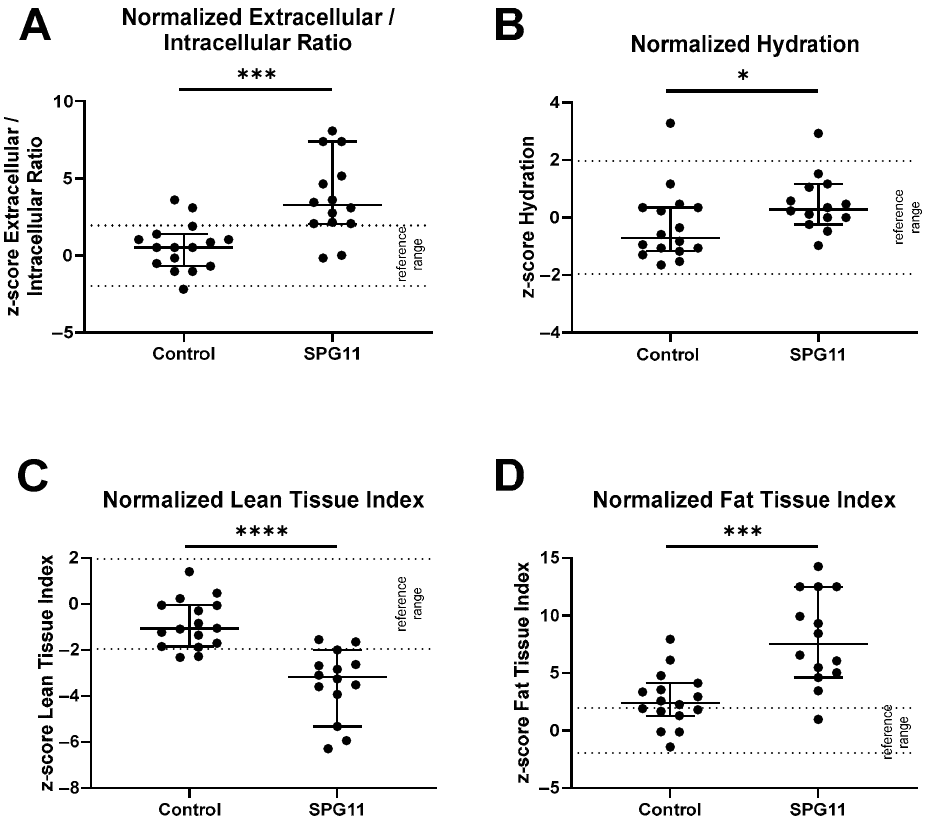
Figure 2. Normalized body composition values in controls and SPG11. Bioimpedance spectroscopy values in controls and SPG11 shown as Z-scores calculated from previously reported sex- and age- adjusted reference values from 1000 healthy subjects. Reference cutoff values had been defined by the 10th and 90th percentiles and are indicated as dotted lines. When comparing normalized values of SPG11 vs. controls, there was a significant difference in ( A ) normalized extracellular/intracellular fluid ratio, ( B ) hydration, ( C ) lean tissue index, and ( D ) fat tissue index. * p < 0.05, *** p < 0.001, **** p < 0.0001, based on non-parametric Mann–Whitney U tests.